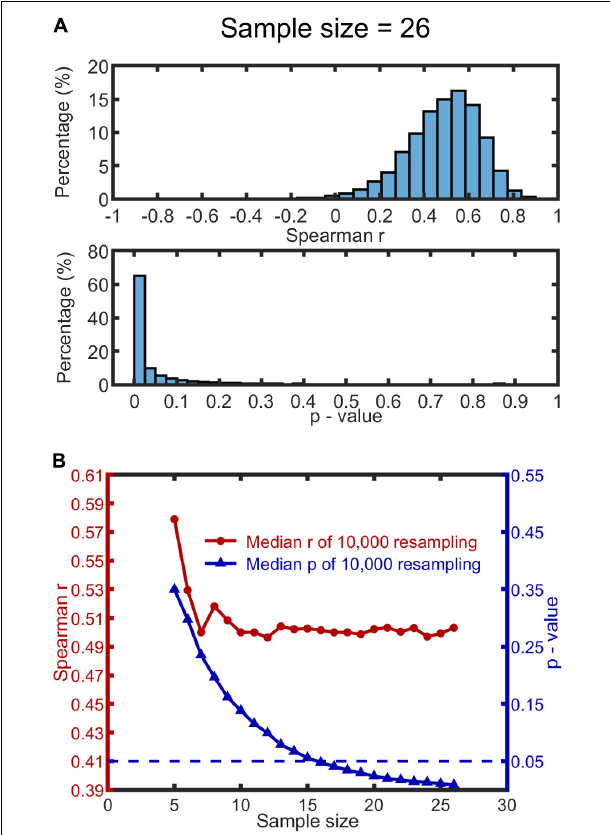
FIGURE 4 | Bootstrapping results based on MISC and significant MIPS data ( N = 26). 10,000 bootstrap resamples were drawn for each condition of sample size (range: 5–26), resulting in 10,000 Spearman’s r and p -value for each. (A) A representative histogram of r and p -values when the sample size is 26. The histograms look similar when the sample size ranges from 10 to 26; see all the histograms in Supplementary Material 6 . (B) The red and blue curve show the change of the median r and p -value (based on the 10,000 resamples) as a function of sample size, respectively. The blue dashed line represents p =